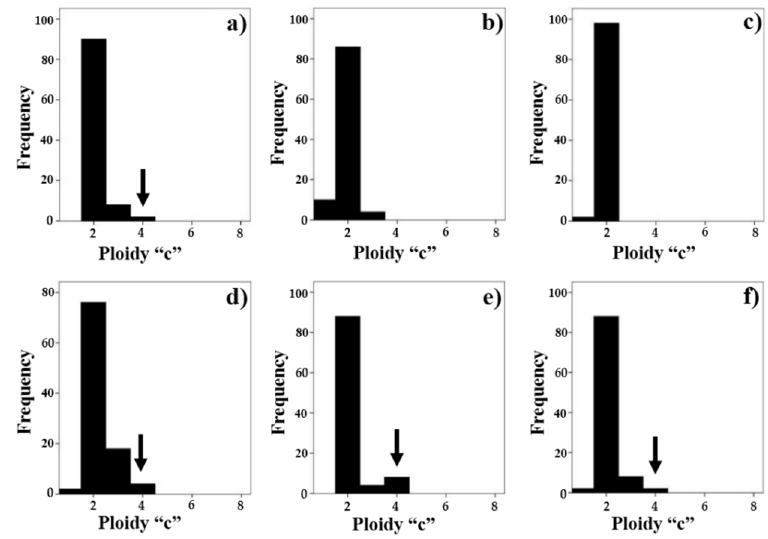
Figure 7. Distribution of the nuclei of nucleated erythroid cells (by ploidy classes) in the bone marrow samples of control ( a ) and irradiated animals on day 1 ( b ), day 3 ( c ), day 7 ( d ), day 14 ( e ), and day 28 ( f ) after irradiation.